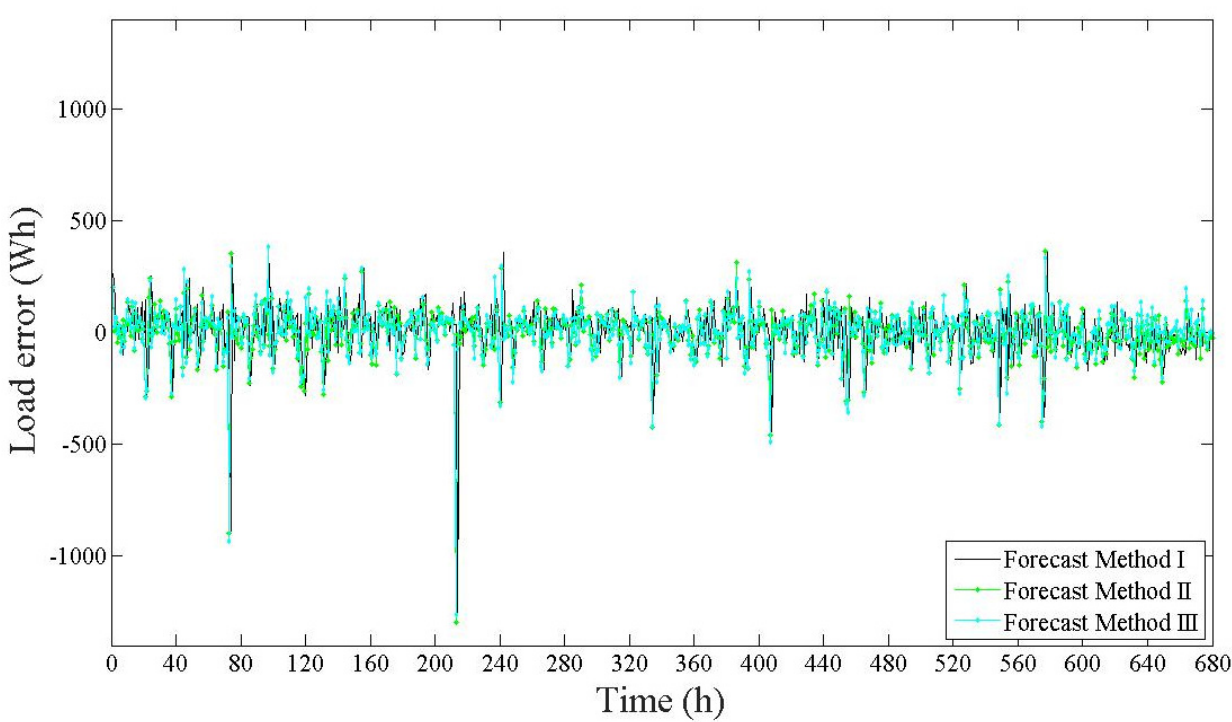
Figure 12. Training error for forecast hourly load of working days of household No 85.